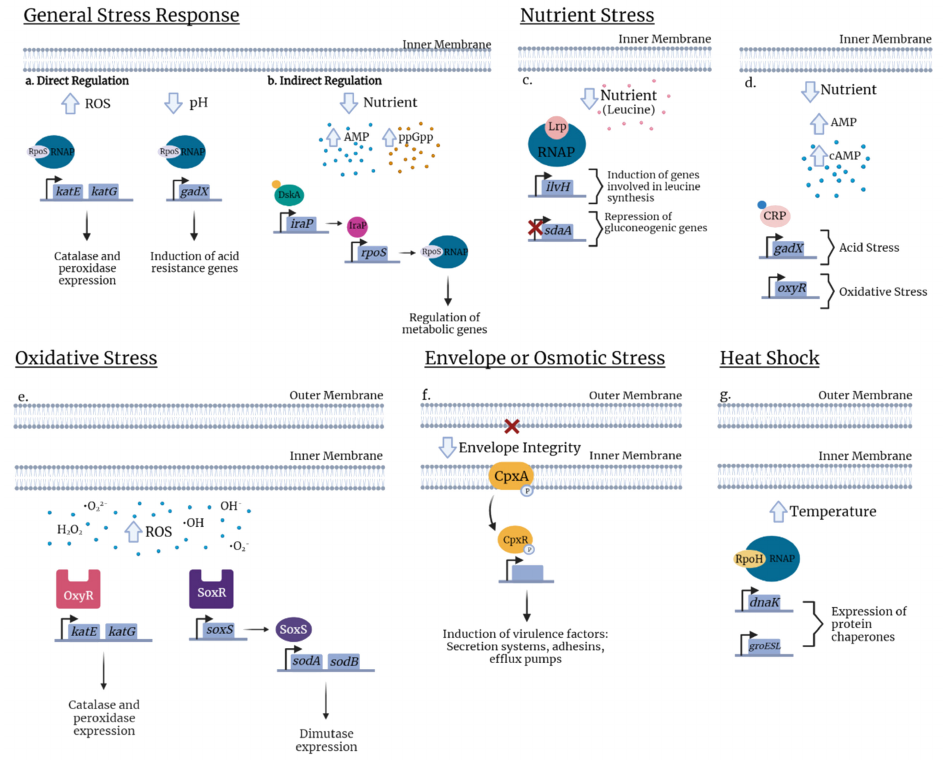
Figure 2. Examples of stress regulators in E. coli . General stress response. ( a ) In response to oxidative stress, RpoS occurs in direct regulation by binding to RNA polymerase (RNAP) and recognizes the promoter thus allowing expression of katG and katE catalase and peroxidase expression. Likewise, in response to low pH, binding of RpoS to RNAP induces expression of the transcriptional regulator, gadX . ( b ) Under nutrient limitation, RpoS is indirectly regulated by the transcription factor DskA or by the alarmone ppGpp (orange circle) that leads to the augmentation of the anti-adaptor IraP and releases RpoS to activate stress gene expression. Nutrient stress. ( c ) Under nutrient deficient conditions, a mis-regulation of cAMP signaling for nutrient availability allows binding of cAMP to the cAMP Receptor Protein (CRP) which activates the protein and specific binding with target DNA sequences regulating the expression of genes involved in acid stress ( gadX ) or in oxidative stress ( oxyR ). ( d ) In nutrient deprivation, exogenous leucine (pink circle) influences the Lrp regulon and modulates Lrp directly. Presence of leucine concentrations represses the transcription of the ilvH promoter whereas in the absence of leucine, ilvH is directly activated by Lrp. Inversely, leucine releases Lrp to bind to the sdaA promoter and activates its expression. Oxidative stress. ( e ) In response to oxidative stress due to excess levels of prooxidants (H 2 O 2 , O 2 , OH), depending on whether the stress is mediated, bacteria respond by two regulatory systems, the peroxide regulon (OxyR) or the superoxide regulon (SoxR/S). OxyR activates genes involved in catalase and peroxidase expression ( katE and katG ). When oxidized, the sensor SoxR activates soxS transcription resulting in expression of superoxide dismutase ( sodA and sodB ). Envelope stress. ( f ) The two-component system consists of the inner membrane, the sensor histidine kinase (CpxA) and the cytoplasmic response regulator CpxR. Envelope stress conditions lead to phosphorylation of CpxA which transfers the phosphate group to CpxR. Phosphorylated CpxR-P functions as a transcriptional regulator which controls the expression of numerous genes including some virulence factors. Heat shock. ( g ) In a simple pathway, during temperature upshift (30 ◦ C to 42 ◦ C), the Heat Shock Response (HSR) is induced by the increase of RpoH levels, primarily due to an enhanced translation of rpoH mRNA and stabilization of the protein. The elevated temperature disturbs protein homeostasis and induces accumulation of misfolded proteins. Chaperones DnaK and GroEL/S which are proteins helping to activate or degrade RpoH and regulate heat shock gene